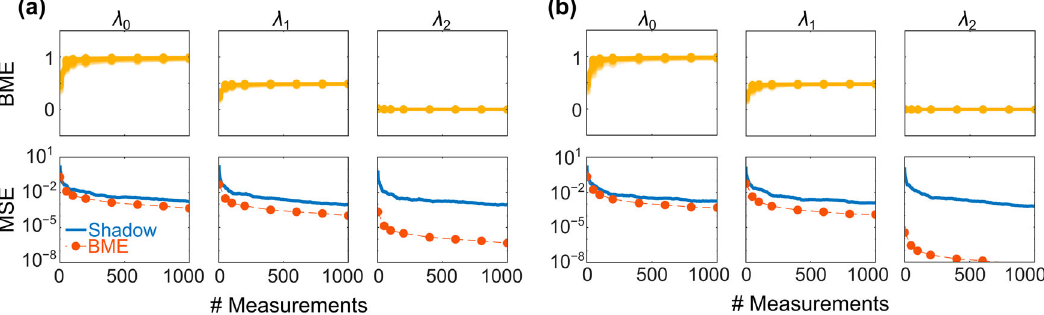
Fig. 6 BME fi ndings utilizing a one-parameter density matrix parameterization [Eq. (12)] and full likelihood [Eq. (13)]. a Results for D = 32. b Results for D = 256. The shadow MSE values from Fig. 1 are plotted again for